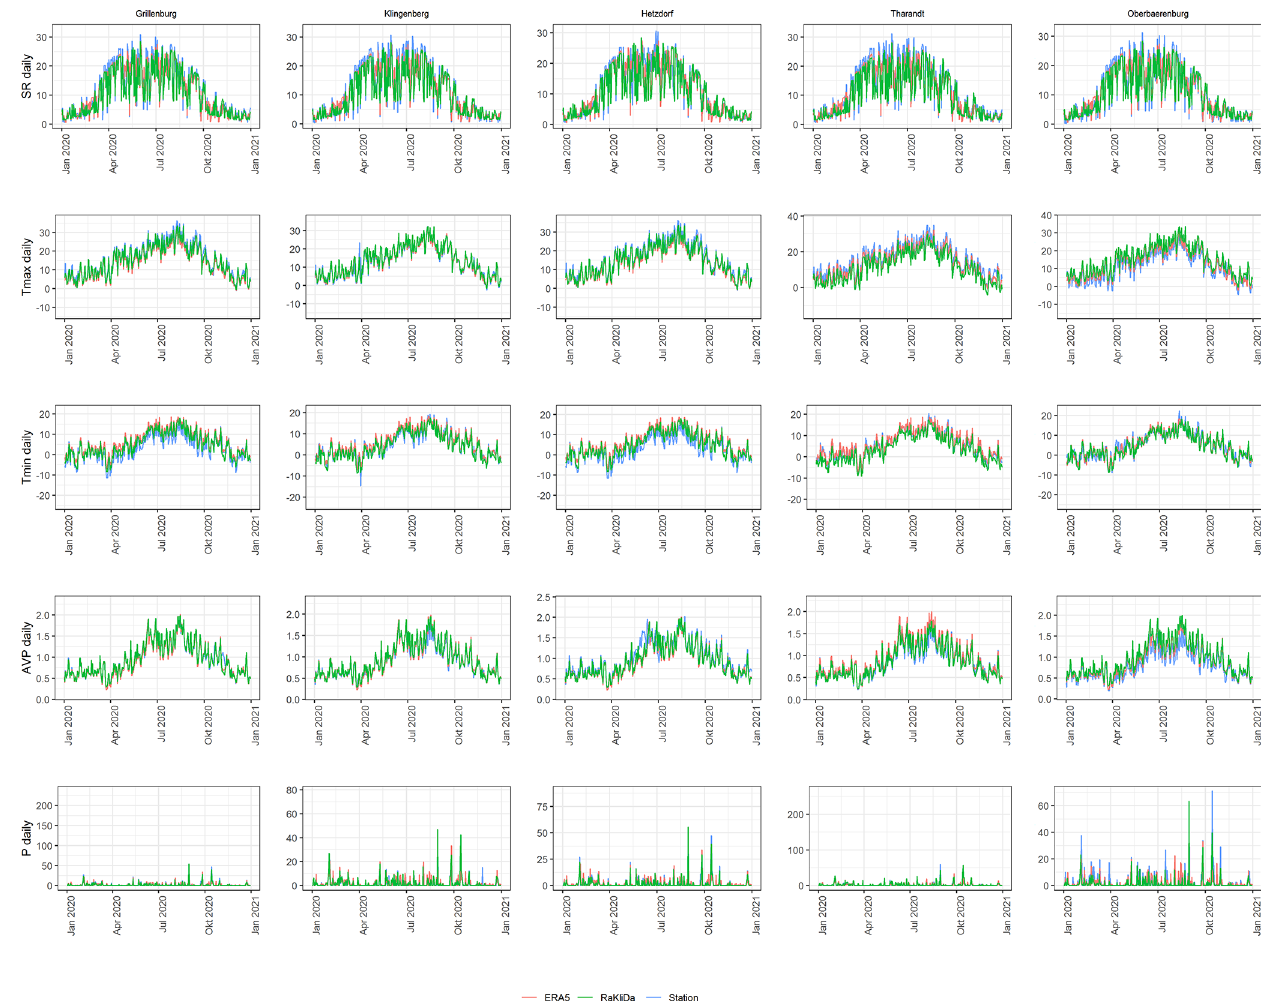
Figure A2. Daily values of meteorological variables for